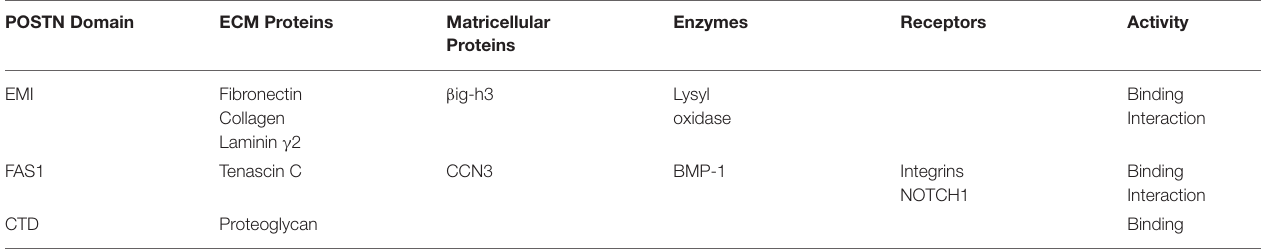
TABLE 1 | Multiple proteins interacting with